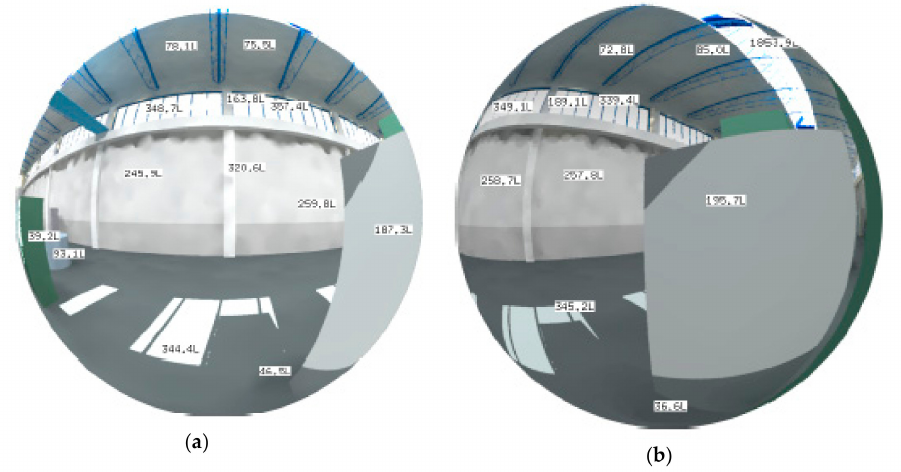
Figure 9. Result of simulated point values of brightness (luminance value cd.m − 2 ) at the workplace using di ff use skylight glazing: ( a ) sunny sky, north view; ( b ) sunny sky, northeast view.